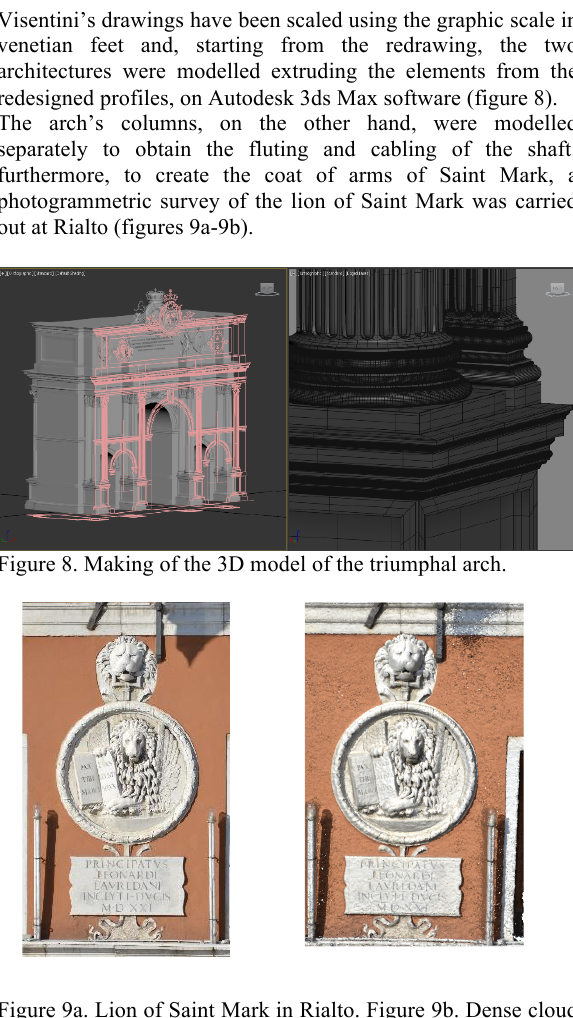
Figure 9a. Lion of Saint Mark in Rialto. Figure 9b. Dense cloud of the photogrammetric model of the lion of Saint